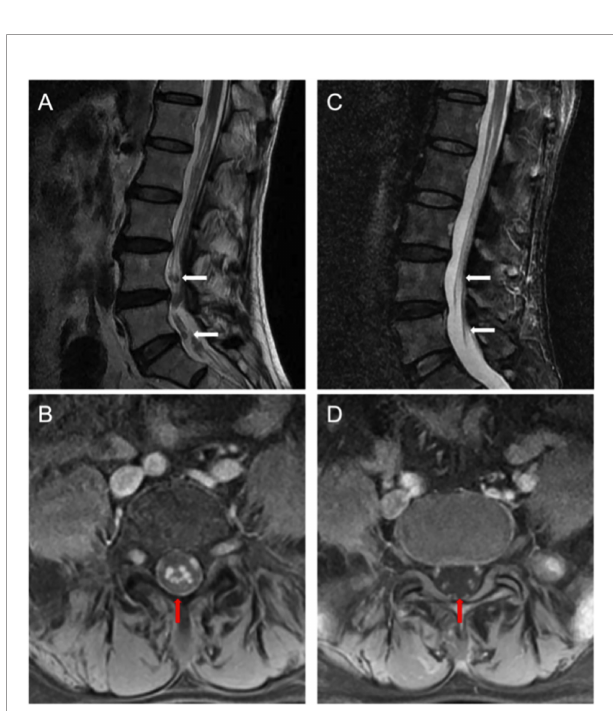
FIGURE 5 | (A) Pretreatment lumbar MRI showed multiple diffuse abnormal signal nods in the cauda equina at lumbar and caudal level. (B) Enhanced transversal scanning. (C) Lesion disappeared in the post-treatment imaging, indicating a complete remission (CR). (D) Enhanced transversal scanning also veri fi ed complete remission of these lesions after BCMA CAR-T cell therapy [high-resolution T2-weighted